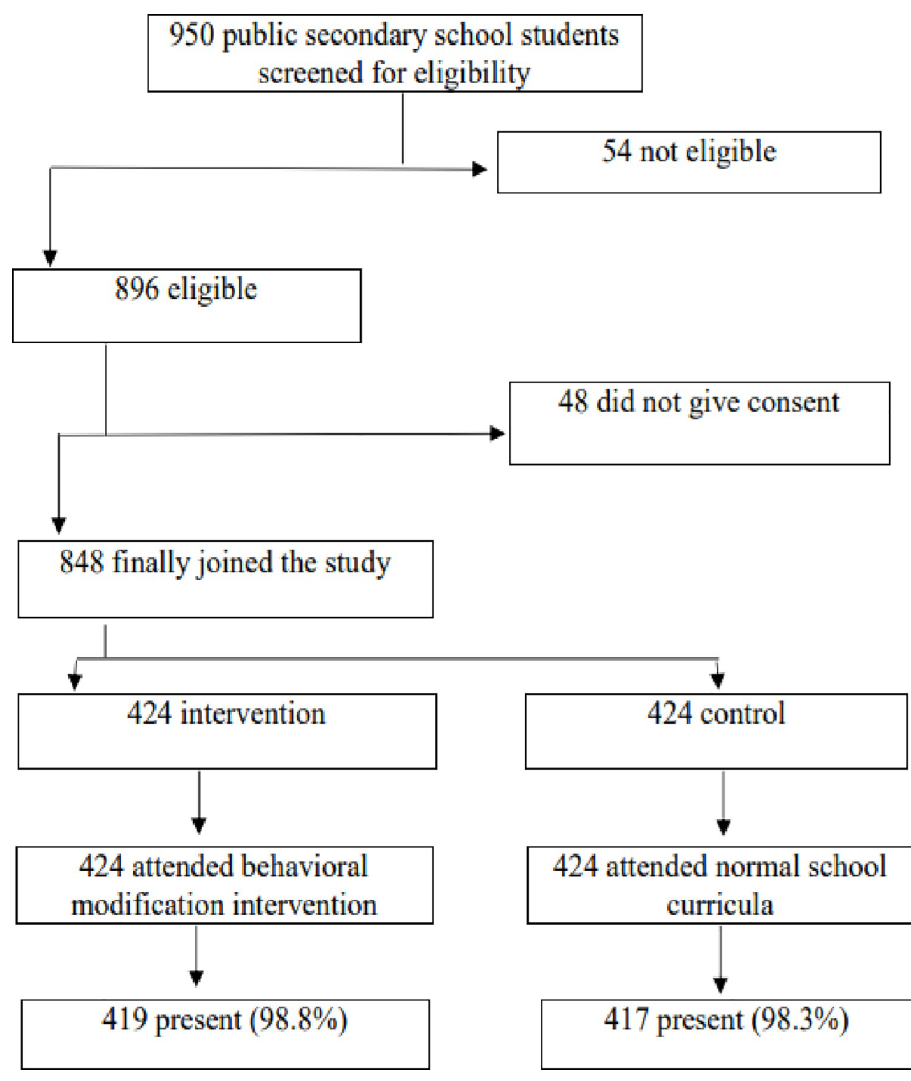
Fig 1. Flow chart of recruitment of